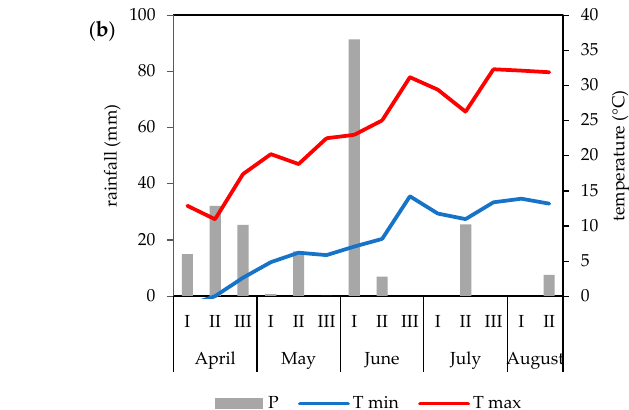
Figure 1. Decadal minimum and maximum temperatures and rainfall distribution during the crop cycle at the two experimental sites, S1 ( a ) and S2 ( b ). Table 1. Climatic information, expressed as mean and standard deviation, from long-term data (1984–2020) of the field experiments.